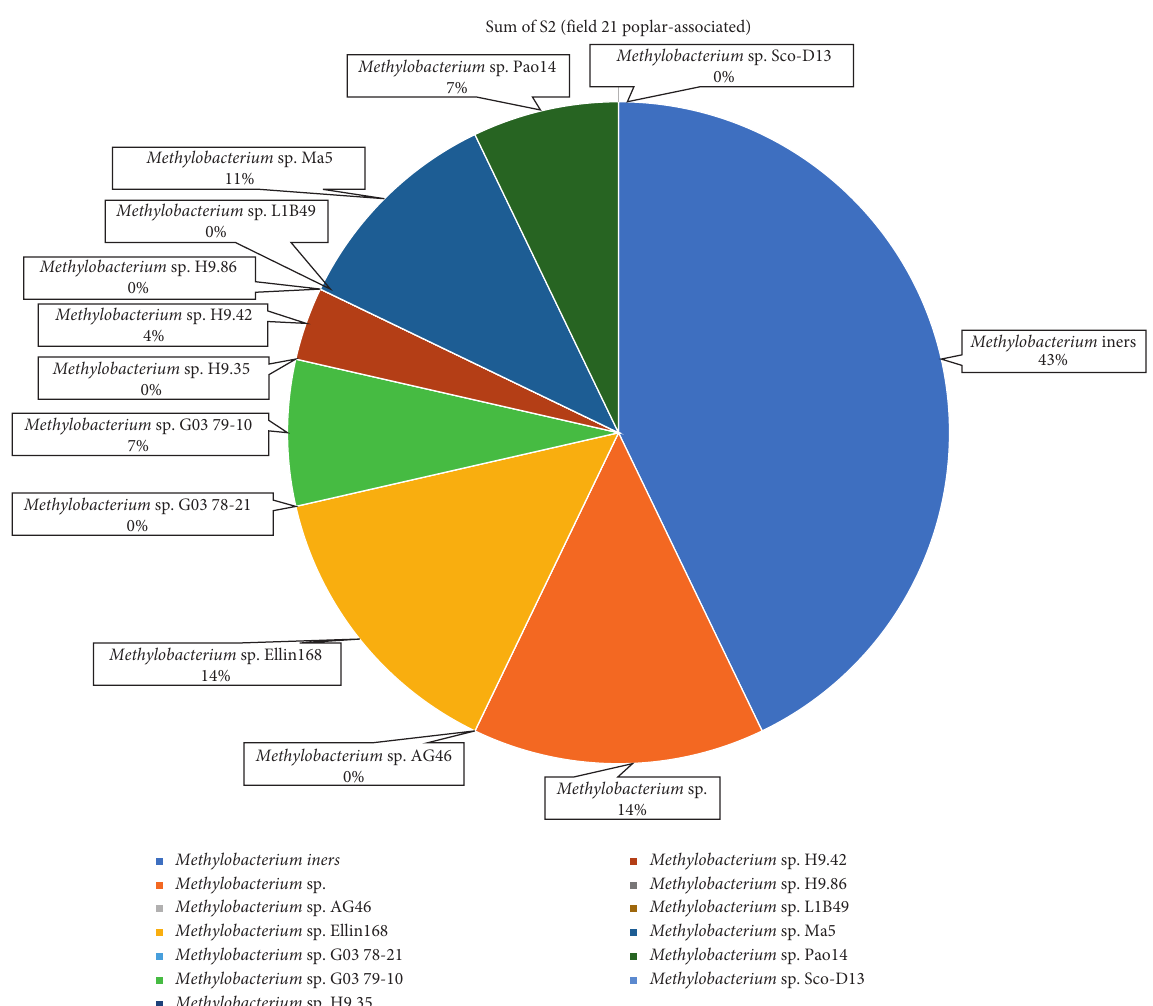
Figure 14: Sum of Methylobacteria sequences from Field